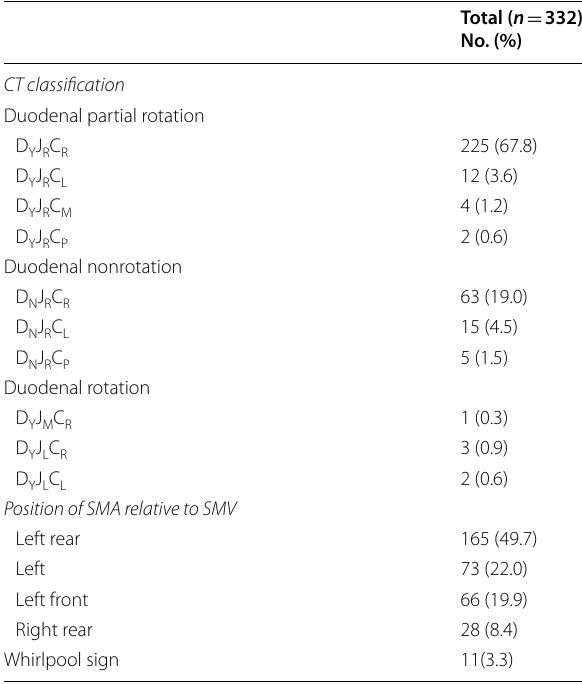
Table 1 Clinical characteristics of 332 adult malrotation patients Table 2 CT findings of 332 adult malrotation